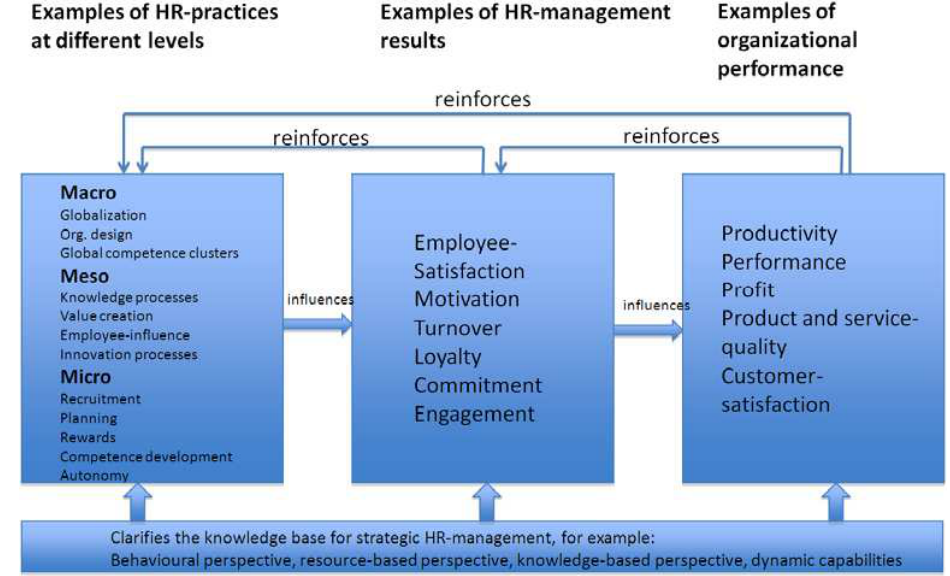
Fig. 3. A model for future research into strategic HR